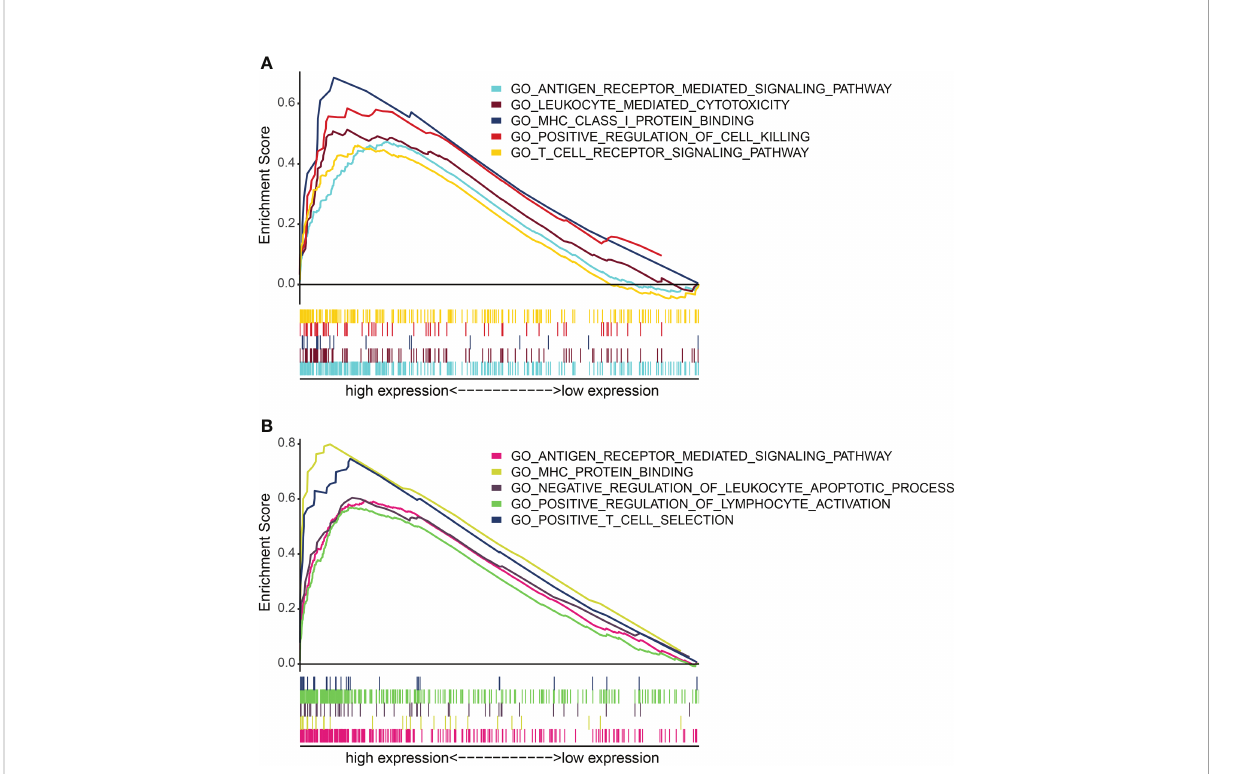
FIGURE 5 GO term enrichment analysis of FLT3LG and RP11_23J18.1 by GSEA method. (A) GO analysis of FLT3LG. (B) GO analysis of